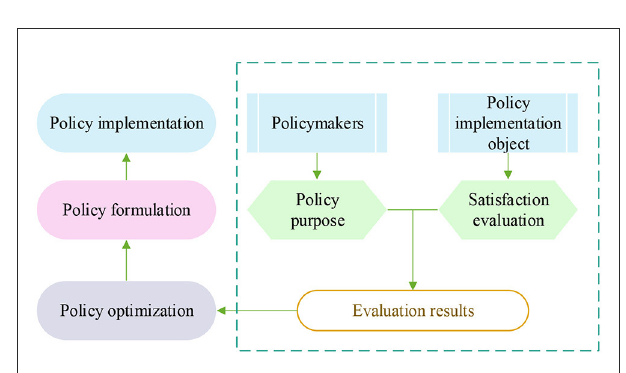
FIGURE3 The feedback mechanism of the evaluation policy of S&T talents.